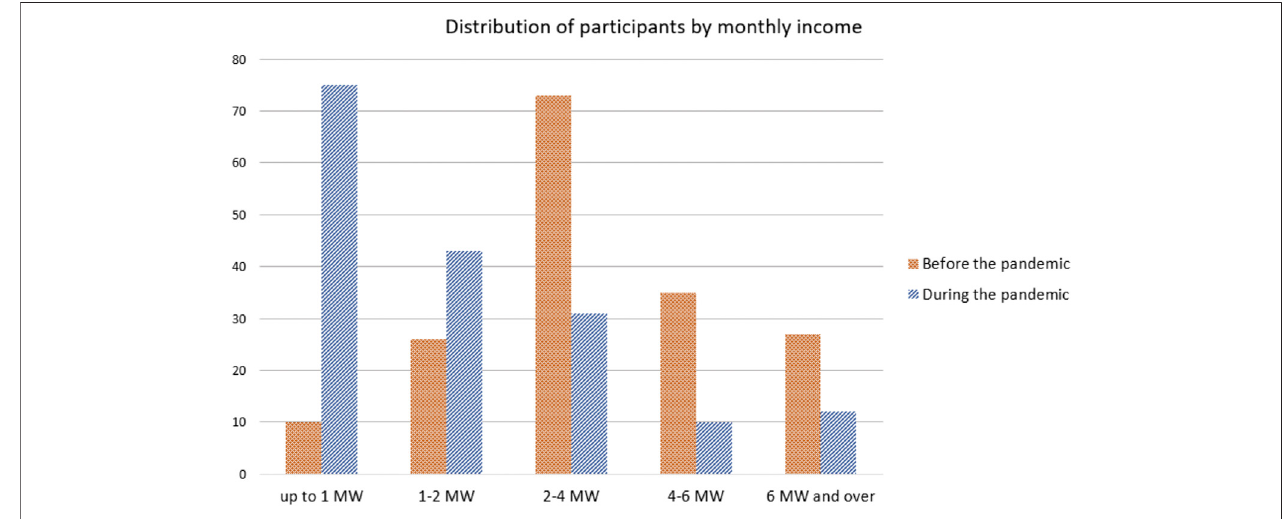
FIGURE 1 | Distribution of participants by monthly income.